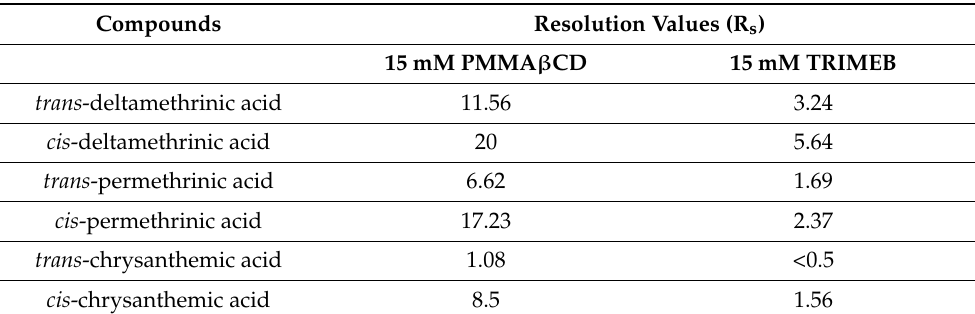
Table 3. The resolution values of the tested pyrethroic acids using permethyl monoamino β -cyclodextrin (PMMA β CD) and permethyl β -cyclodextrin (TRIMEB) chiral selectors at pH